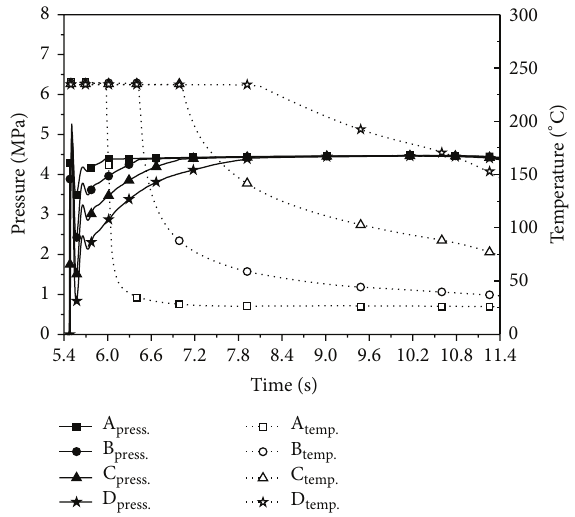
Figure 4: Pressure and temperature profiles at the central point of measurement locations (A, B, C, and